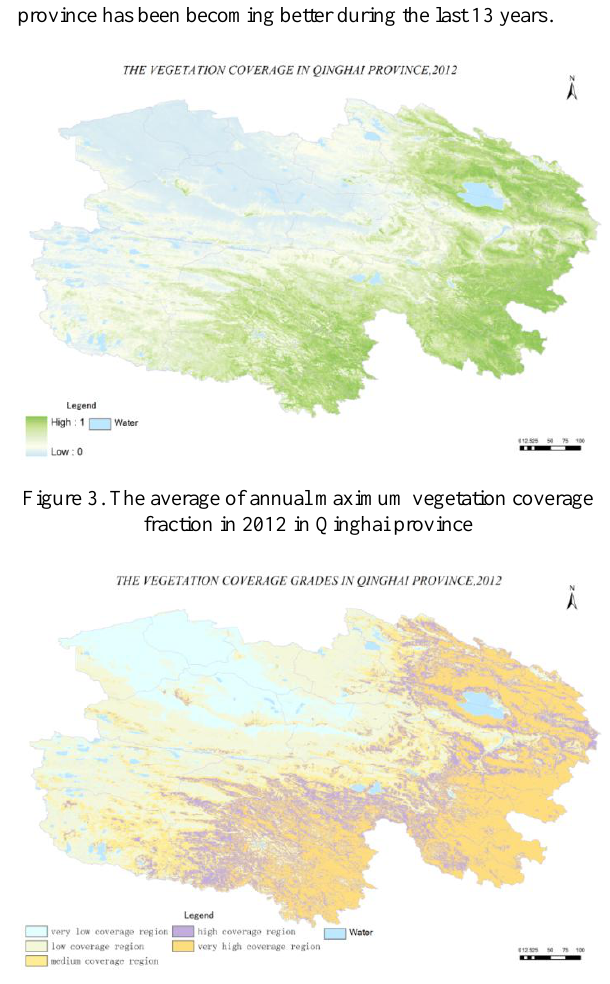
Figure 4. The average of annual maximum vegetation coverage fraction in 2012 in Qinghai province (using different levels)